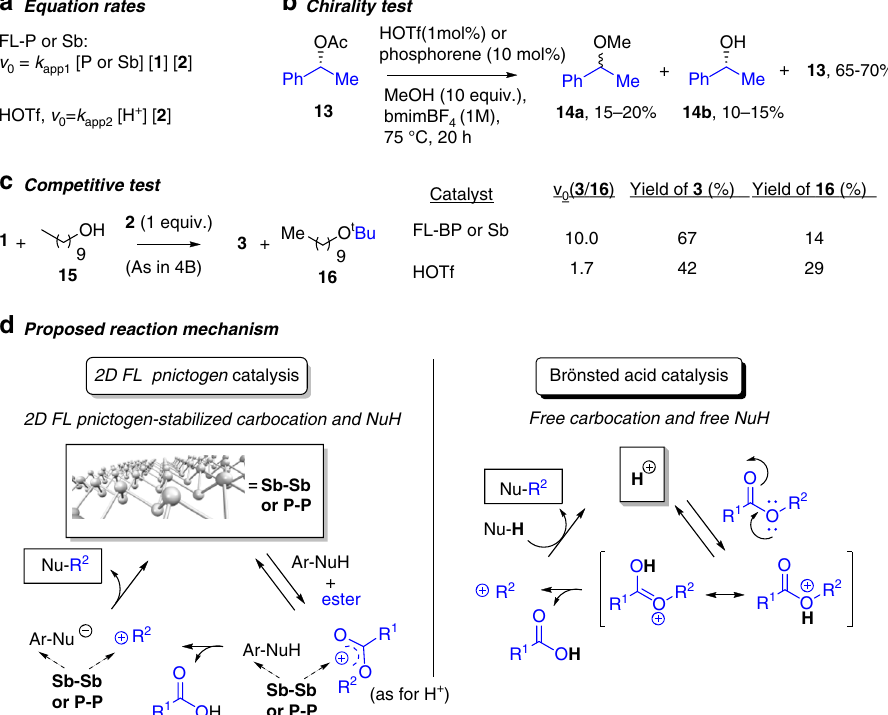
Fig. 4 Mechanistic studies. Experimental evidences and proposed mechanisms for FL-BP, FL-Sb, and HOTf catalyzed-alkylation of nucleophiles with esters in bmim-BF